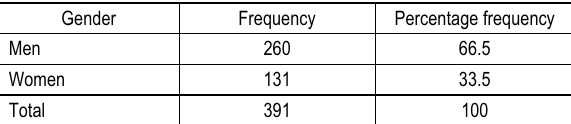
Table 1. Distribution of the percentage frequency of